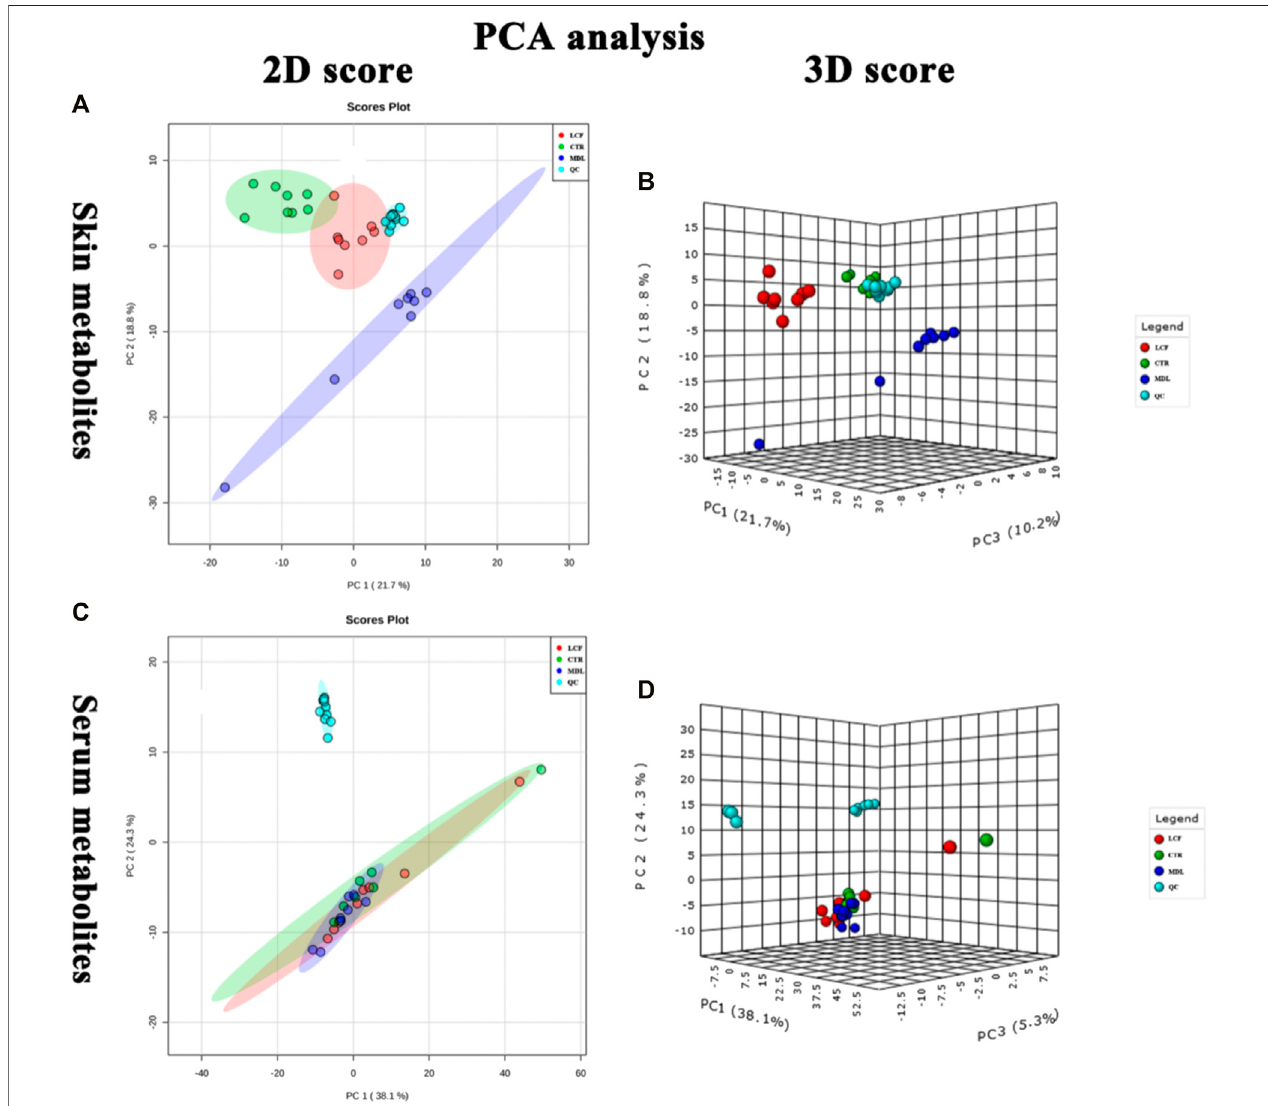
FIGURE4| QCsamplesassessment; (A) PCA2Dplotofskinmetabolites; (B) PCA3Dplotofskinmetabolites; (C) : (A) PCA2Dplotofserummetabolites; (D):(A) : PCA 3D plot of serum metabolites.